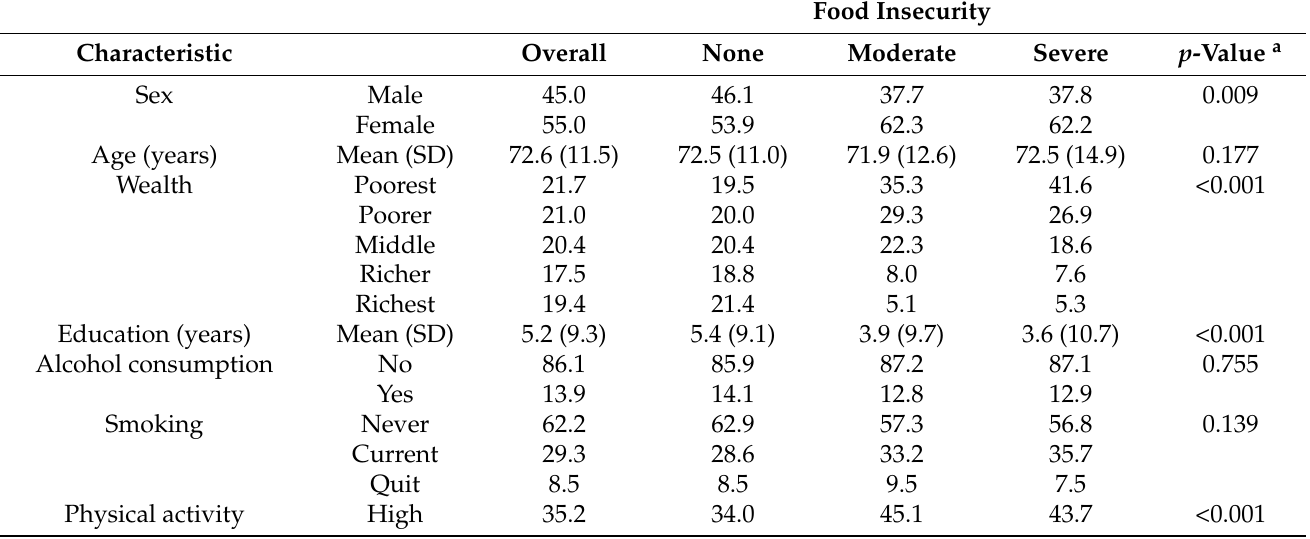
Table 1. Sample characteristics (overall and by food